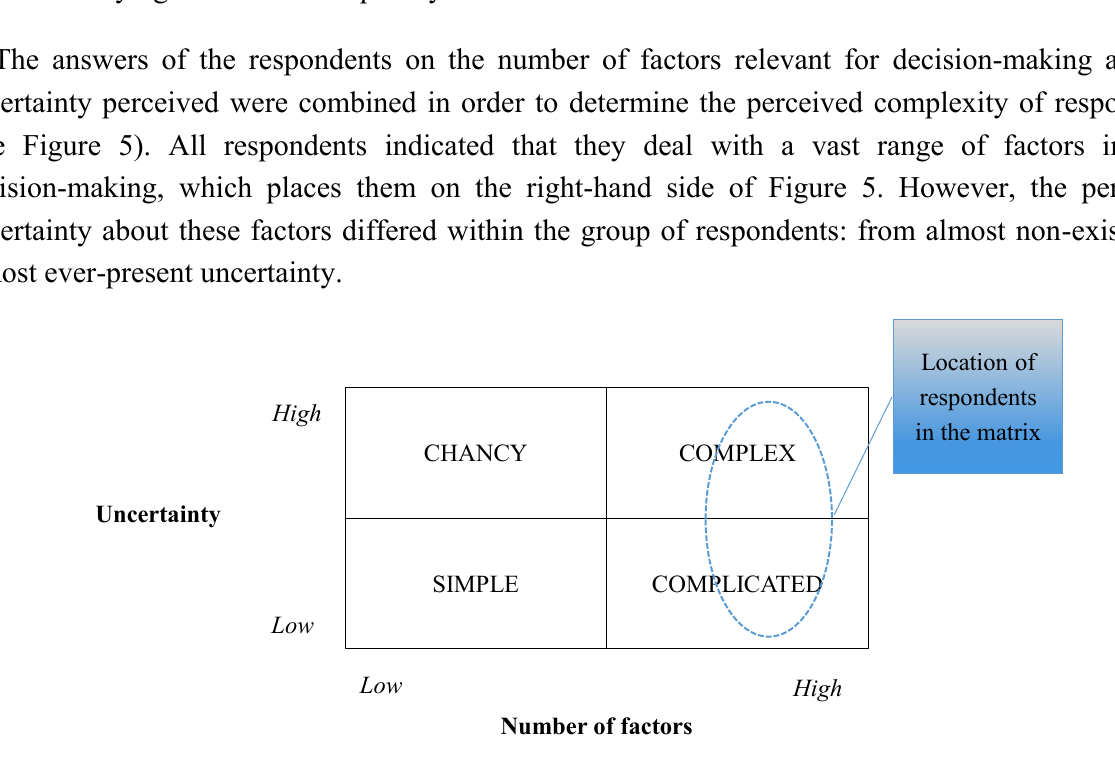
Figure 5. Classification of the respondents’ perceived complexity of their decision-making situation based on interview